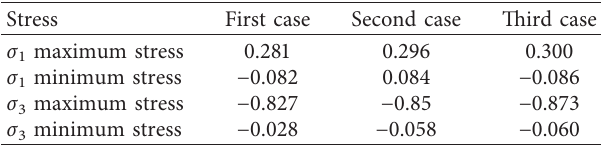
Table 3: First and third principal stresses of the lock chamber under various operating conditions (unit: MPa).